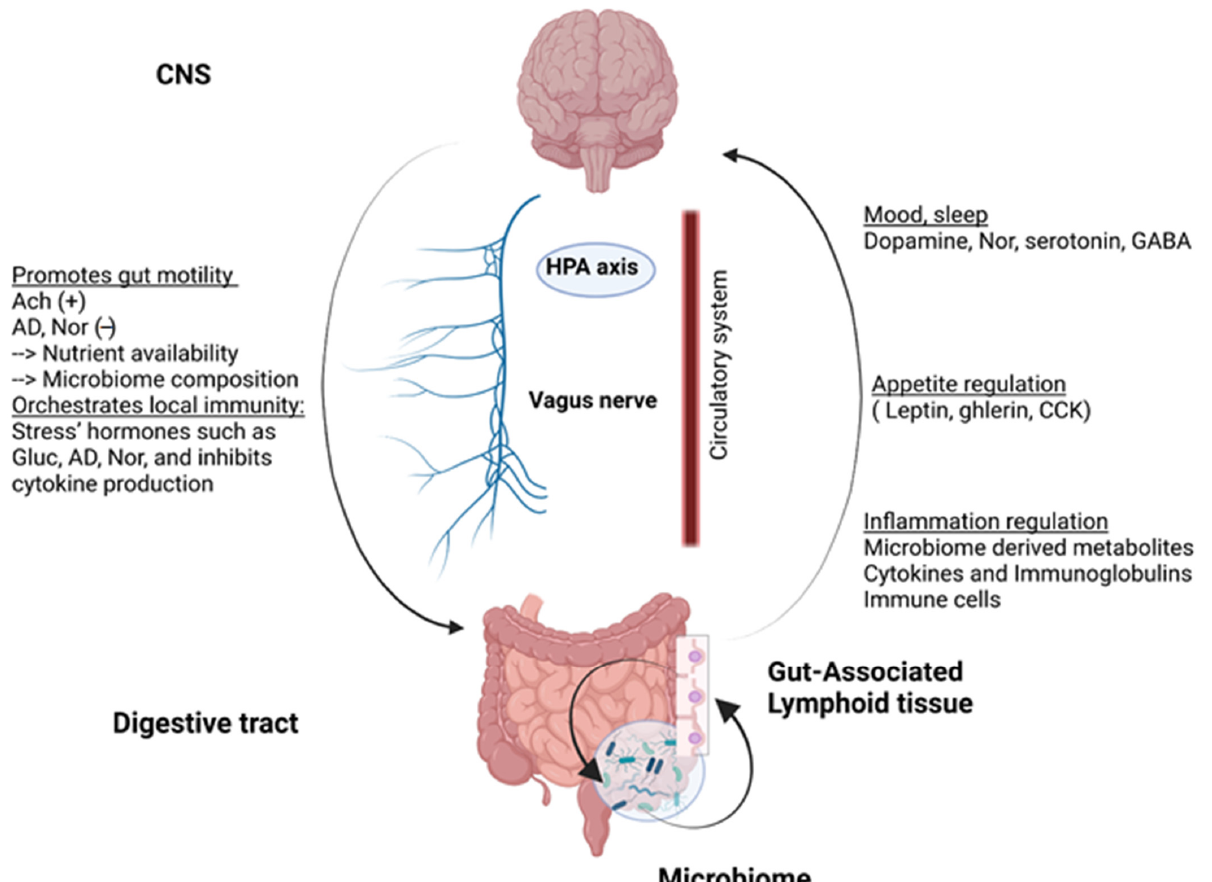
Figure 1. Gut ‐ brain axis, a multidirectional communication system: Communications take place through the neuroendocrine pathway. While acetylcholine (Ach) promotes smooth muscle contractions, adrenergic neurons can decrease bowel movement. Moreover, stress hormones, mainly glucortico ĩ ds (Gluc), adrenaline (AD), and noradrenaline (Nor), create a strong suppressive response on the immune system. On the other side, the digestive system can release large amounts of bioactive hormones and molecules in cooperation with the constantly interacting microbiome and immune system. HPA: hypothalamic ‐ pituitary ‐ adrenal axis, GABA: γ‐ aminobutyric acid, CCK: cholecystokinin.